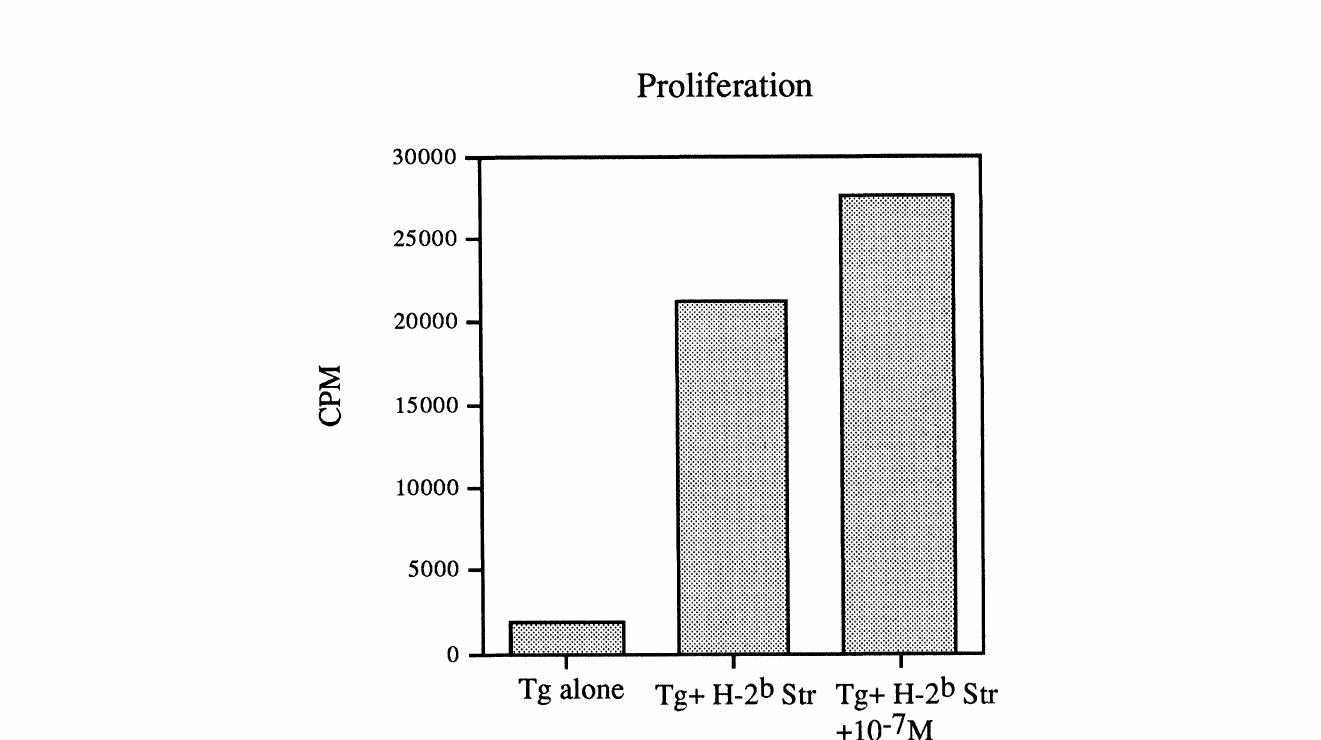
FIGURE 7 Transgenic cells selected by H-2 stroma in the absence or presence of nominal peptide are functionally mature. CD4-CD8 cells positively selected in the absence or presence of nominal LCMV peptide (10 -7 M), proliferate in response to fresh antigen-presenting cells loaded with a higher concentration of LCMV peptide (10 -6 M). The transgenic cells when cultured alone show no such